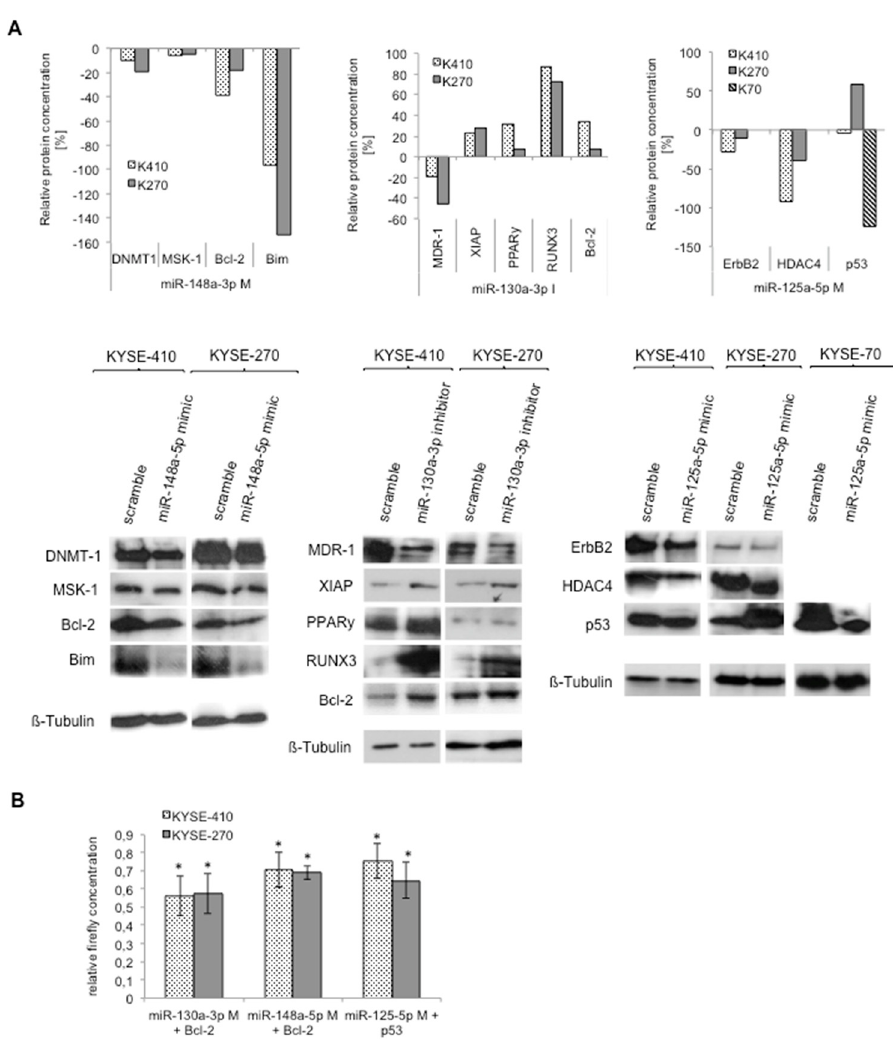
Figure 6. Specific miRNA signatures of resistant cell lines target various resistance-relevant pathways: western blotting and luciferase assays. ( A ) Protein expression of potential targets of respective miRNAs, measured with western blot in KYSE-410 and KYSE-270 cells (and in case of p53 analysis in KYSE-70 cells); and ( B ) luciferase assay after miRNAs transfection. Relative firefly concentration of target protein of interest was measured with the Dual Glo Luciferase Kit 24 h after transfection with miRNA precursor molecules. DNMT-1: DNA (cytosine-5)-methyltransferase 1; MSK-1: mitogen and stress activated protein kinase 1; Bcl-2: B-cell lymphoma 2; MDR1: multidrug resistance protein 1; XIAP: X-linked inhibitor of apoptosis protein; RUNX3: Runt-related transcription factor 3; PPARy: Peroxisome proliferator-activated receptor gamma; HDAC4: Histone deacetylase 4; ErbB2: Receptor tyrosine-protein kinase; K270: KYSE-270, K410: KYSE-410, K70: KYSE-70; M: mimic; I: inhibitor; Scr: Scramble; and *: significance ( p ≤ 0.05).